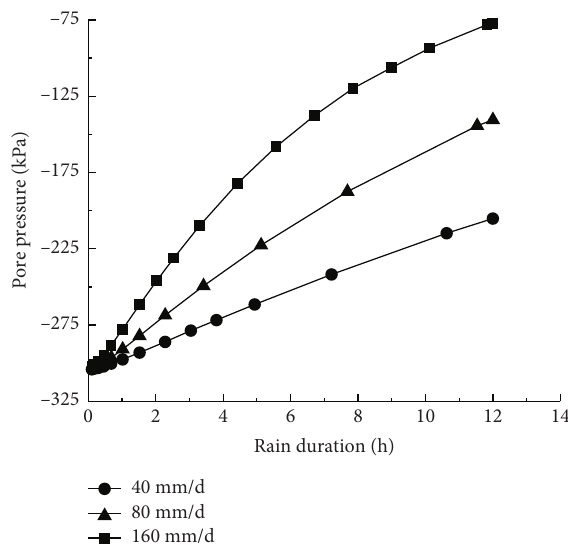
Figure 8: Curves of fluid velocity-rain duration at point A under different rainfall